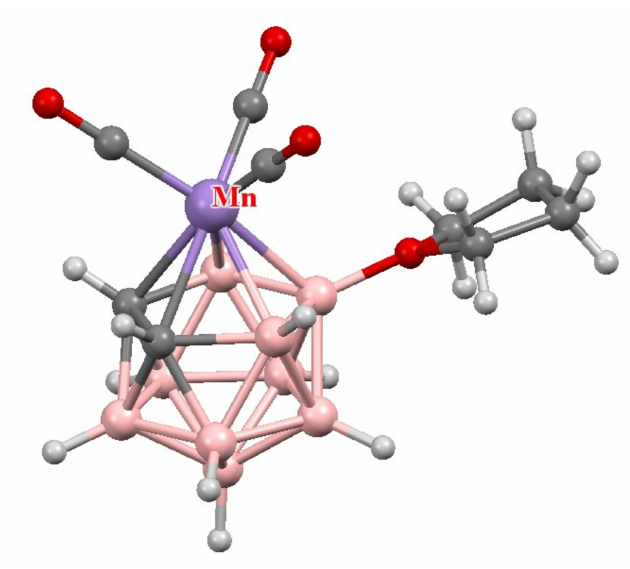
Mn(8-(CH 2 ) 4 O-1,2-C 2 B 9 H 10 )], as well as its C,C (cid:48) -dimethyl derivative [3,3,3-(CO) 3 -3-Mn(8- (CH 2 ) 4 O-1,2-Me 2 -1,2-C 2 B 9 H 8 )], can also be prepared directly from the parent